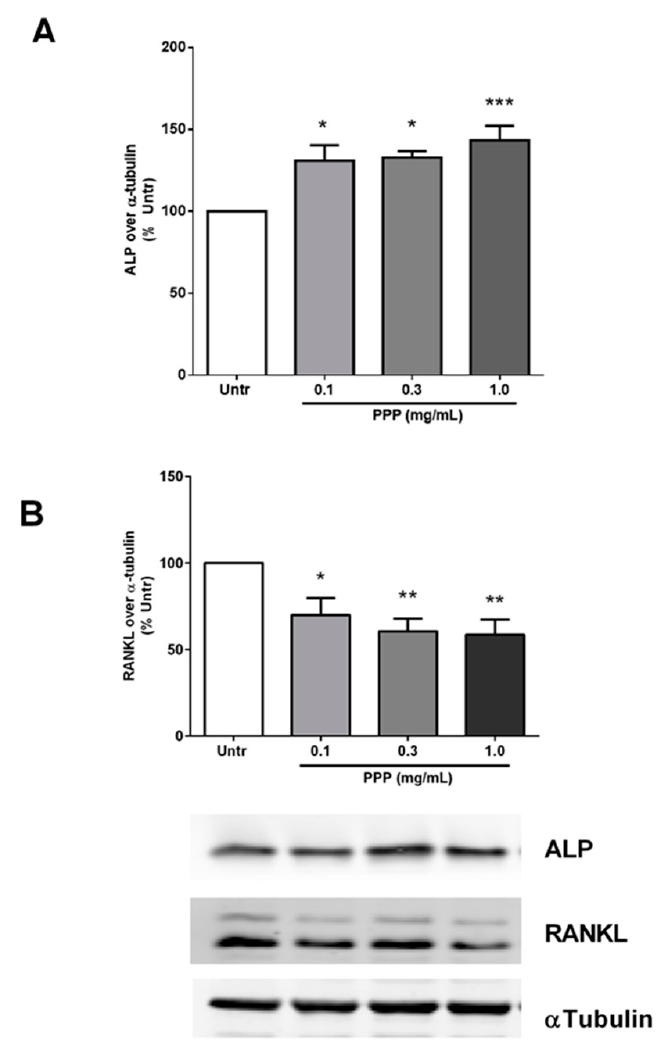
Figure 2. Phosvitin phospho-peptide (PPP) increases ALP and decreases RANKL in osteoblastic cells. Confluent monolayers of MC3T3-E1 cells were treated for 72 h with different concentrations (0.1 – 1.0 mg/mL) of PPP prior to being lysed and immunoblotted for ALP ( A ) and RANKL ( B ). A representative set of immunoblots is shown. Data are mean ± SEM from 5 – 6 independent experiments. *, ** and *** indicate p < 0.05, p < 0.01 and p < 0.001 respectively, as compared to the untreated control group.